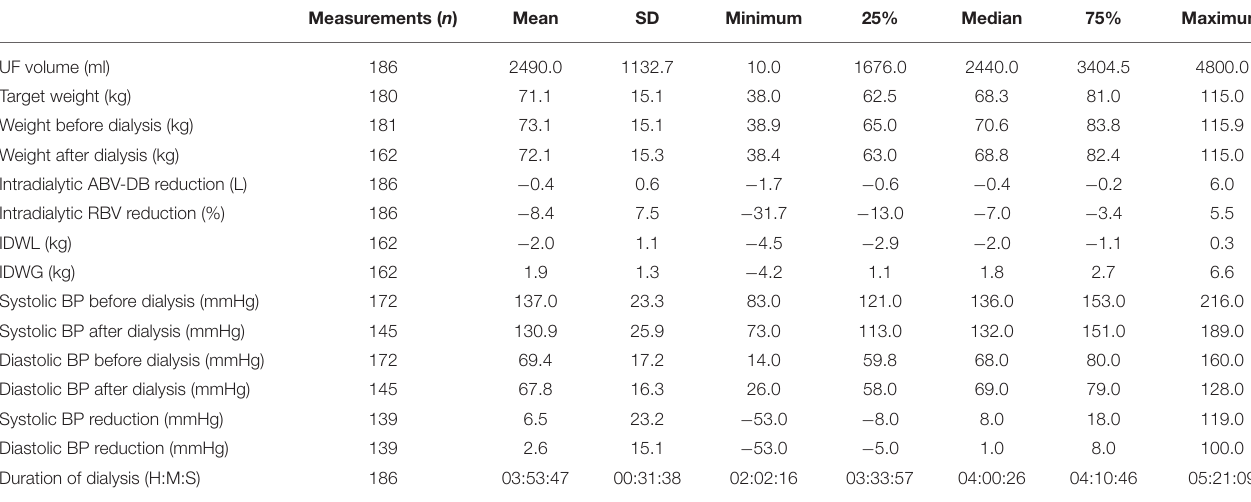
TABLE 2 | Fluid status, weight and blood pressure (based on 86 patients, 186 sessions).